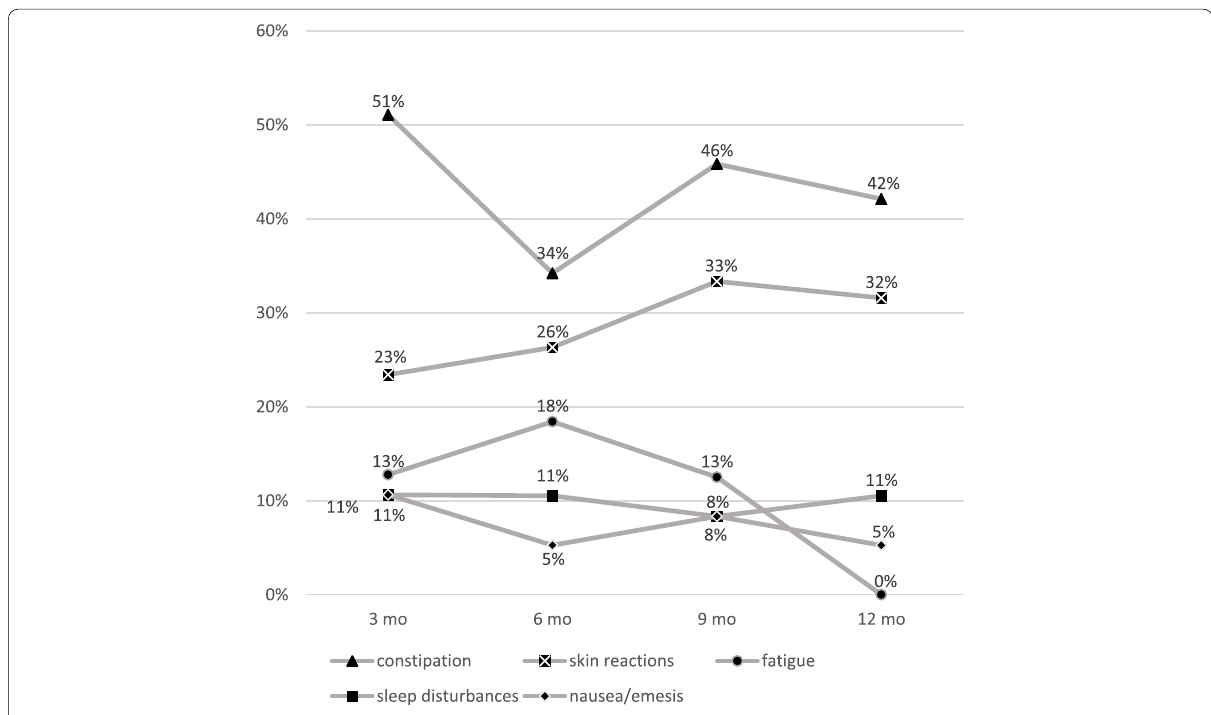
Fig. 3 Specific adverse events. Specific adverse events in proportion to all reported AEs over 12